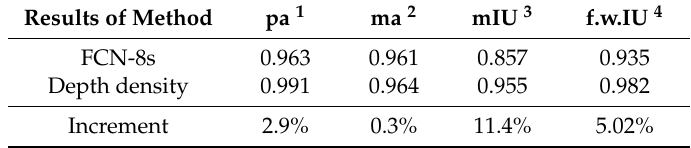
Table 2. Four metrics of FCN-8s and the refined results by depth density on the validation